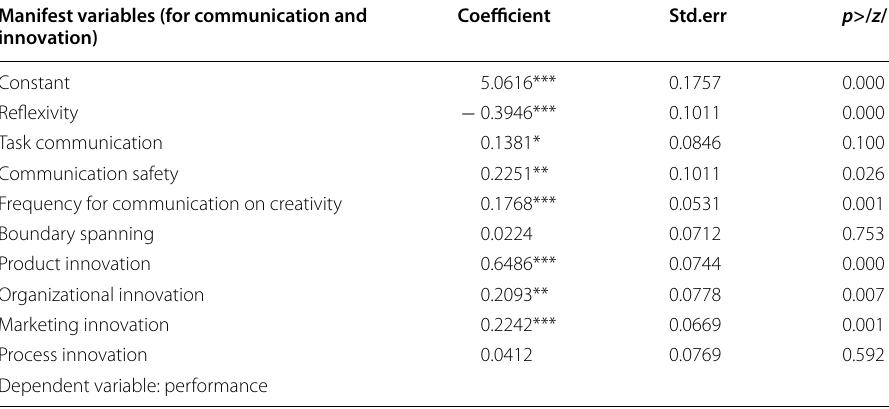
***Significant at 1%, **significant at 5%; *significant at 10%